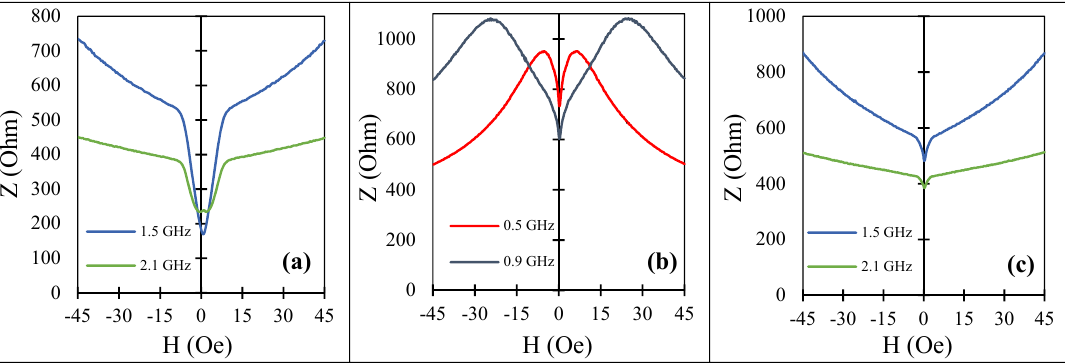
Figure 8. MI vs. magnetic field for amorphous Co 66.6 Fe 4.28 B 11.51 Si 14.48 Ni 1.44 Mo 1.69 microwires (sample No1): ( a ) as-cast, ( b , c ) after current annealing with I an = 30 mA for 30 min for different frequencies. Z corresponds to the impedance amplitude.